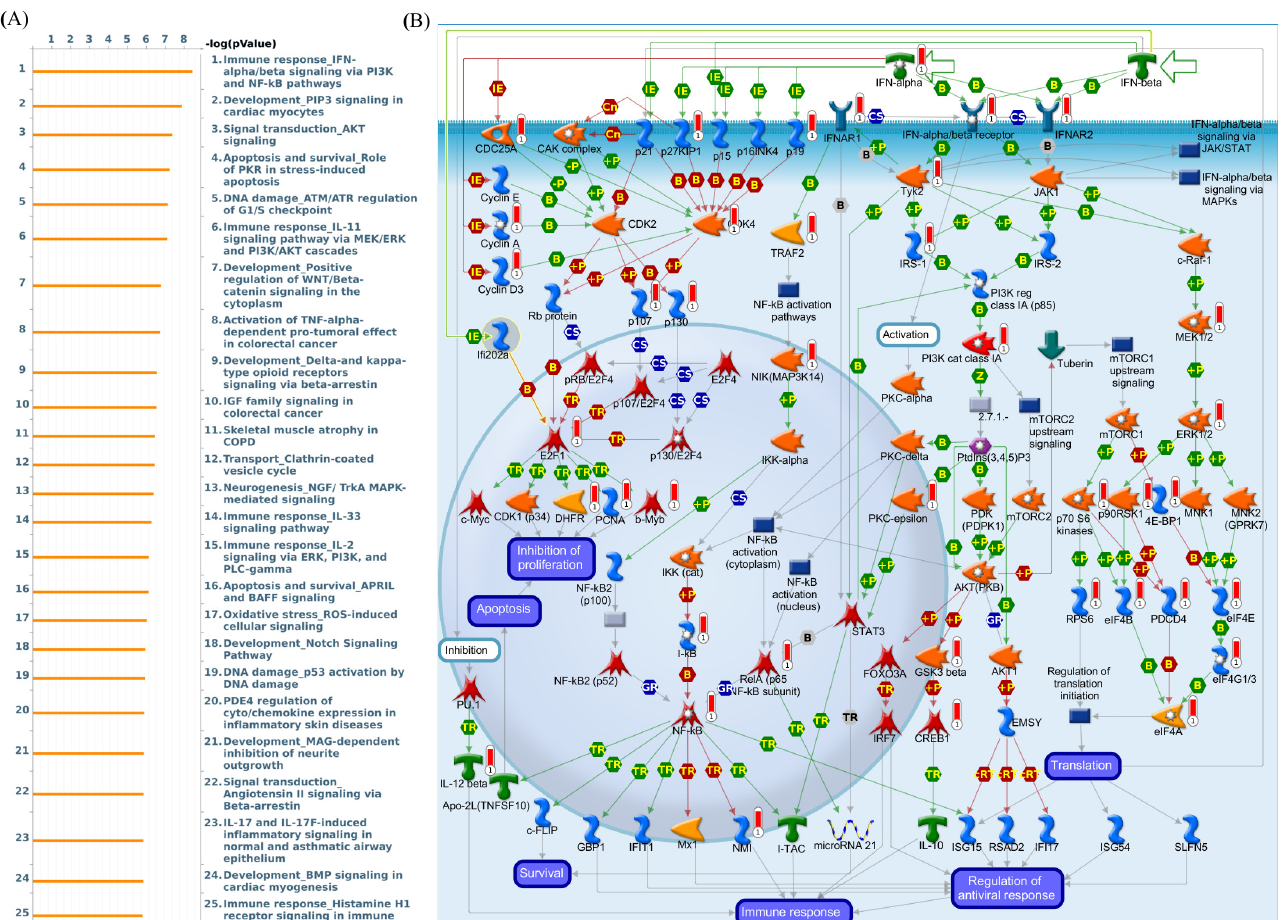
Figure 8. L-Antigen 2B (LAGE2B) is particularly overexpressed in breast cancer patients . ( A ) In order to discover prospective gene networks and pathways impacted by the chosen genes, we exported LAGE2B co-expressed genes from TCGA and METABRIC breast cancer datasets to the MetaCore pathway analytical tool. ( B ) The MetaCore pathway analysis of “biology processes” indicated that “immune response_IFN-alpha/beta signaling via PI3K and NF- κ B”-related pathways were correlated with breast cancer development.